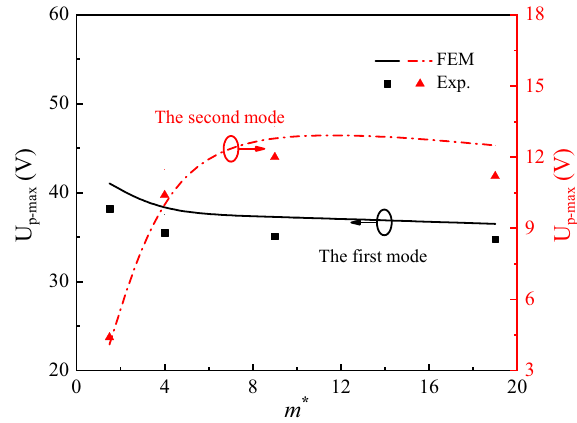
Figure 12. The U p-max vs m * curves at the first and second modes for